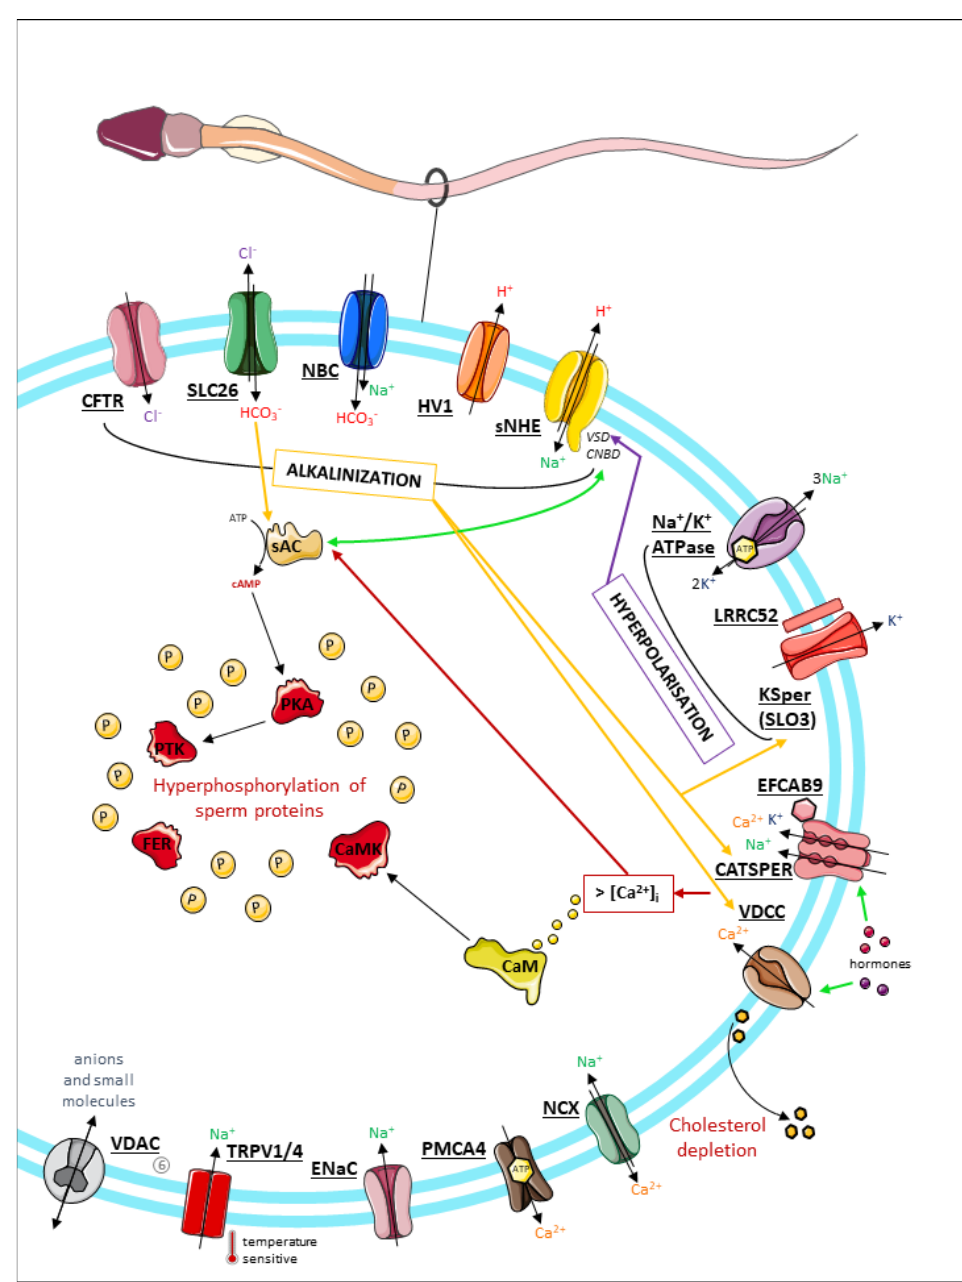
Figure 1. Scheme summarizing the main molecular, biochemical, and electrophysiological events associated with sperm capacitation and the main ion channels/transporters involved in the process. The first subset of ion channels (SLC26 family interacting with CFTR, NBC, Hv1, and sNHE) are responsible for intracellular alkalinization of the sperm by internalizing bicarbonate or extruding protons. The subsequent pH increase is responsible for sAC activation, which induces an increase in intracellular cAMP. cAMP is a key element of sperm signaling during capacitation, in particular, by mediating PKA-dependent phosphorylation events and also by promoting the activity of other ion channels, such as CatSper, VDCC, and KSper (yellow arrows). CatSper and VDCC mediate Ca 2+ entry into spermatozoa and are sensitive to the stimulation of progesterone and other hormones present in the female genital tract. The increase in intracellular Ca 2+ concentration also participates in the activation of sAC (red arrow). In addition, membrane hyperpolarization by cation extrusion through KSper and Na + /K + ATPase also influences voltage-sensitive actors, such as sNHE (violet arrow). It also temporally regulates the activity of other channels, as it inhibits CatSper and Hv1 (Vyklicka and Lishko, 2020).Of note, Hv1 is absent from murine spermatozoa; this voltage-gated